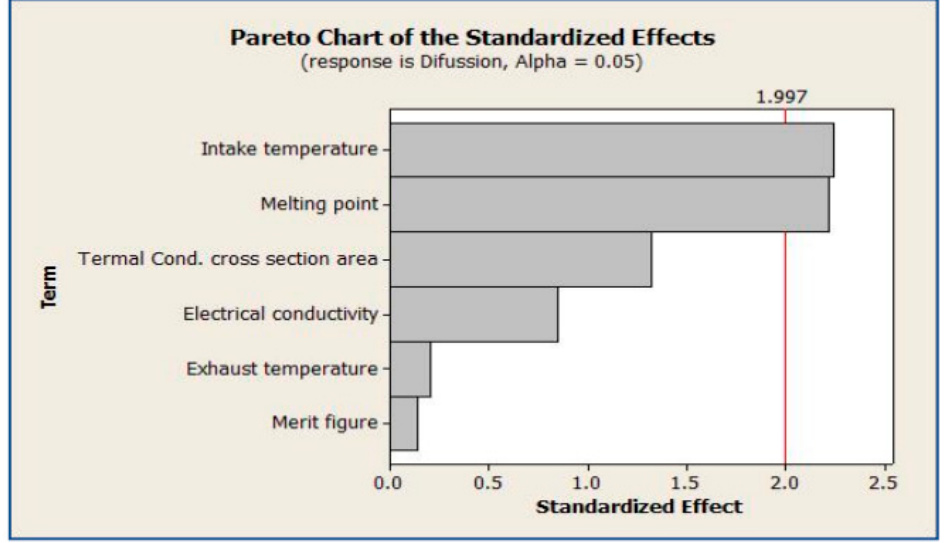
Figure 11. The significant parameters affected by the thermal conductor’s failure.